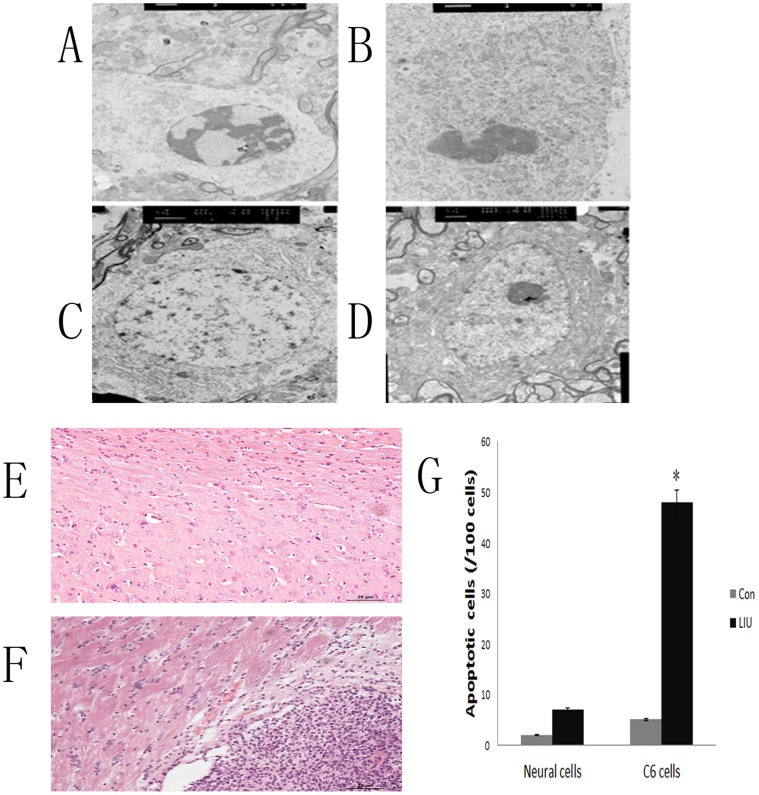
The changes in ultrastructures and apoptosis of C6 cells and astrocytes in rat brain observed by TEM (A–D), HE staining (E–F) and TUNEL assay after LIUS sonication.C6 cells of rat brain glioma are shown pre-sonication (A). Apoptotic body is observed post-sonication in C6 cells (B). Neural cell pre-sonication is shown (C). Neural cell membrane deformed and chromatin aggregation is observed post-sonication (D). Scale bars for ultrastructure are 200 nm. Normal rat brain tissues (E) and glioma tissues (F) 6 h post-sonication are shown without obvious destruction. Scale bar = 20 µm. *P<0.05 compared with the control group.